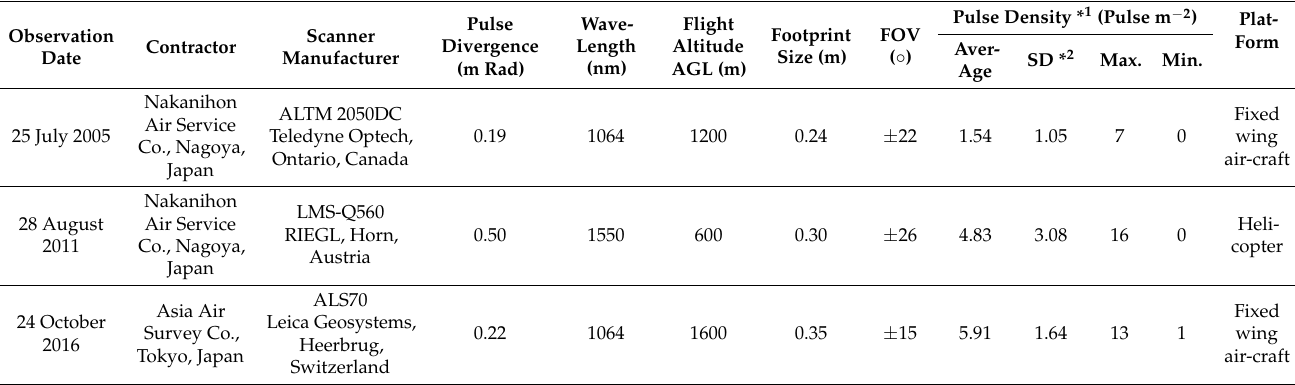
Table 1. Summary of light detection and ranging (LiDAR)